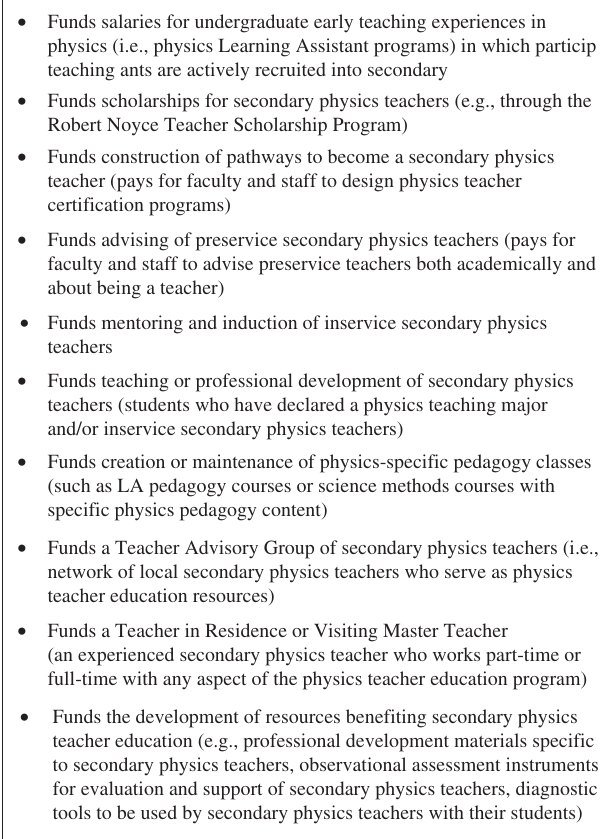
FIG. 1. Funded activities supporting physics teacher prepara- tion. When only a fraction of an award is dedicated to these activities, only that fraction of the award is counted as supporting physics teacher